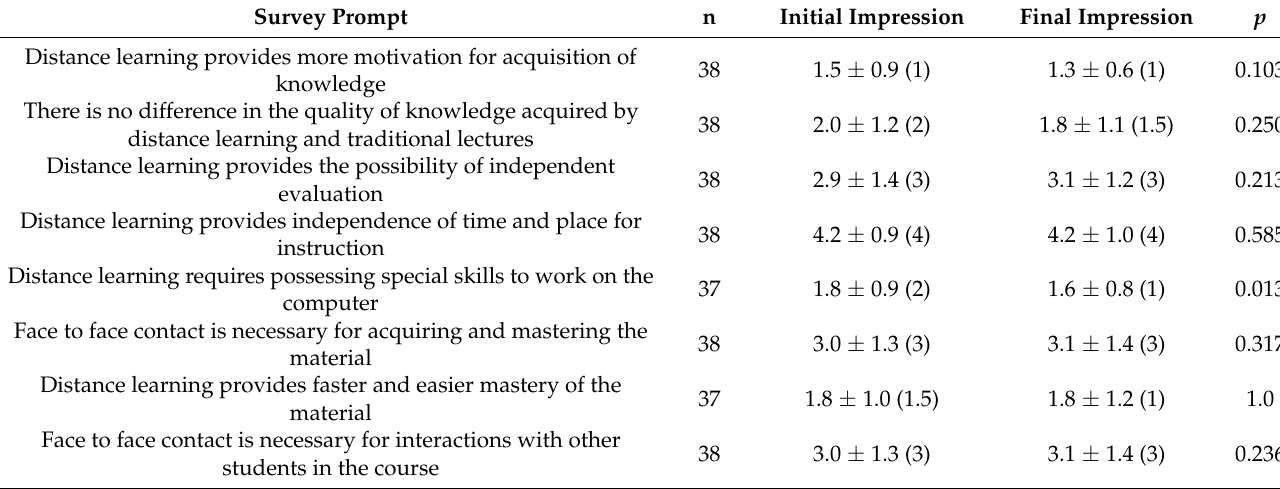
Table 3. Mean Likert scores associated with the following survey questions: before you started this course, how well did you agree with each of the following statements? and after completing the course, how well do you agree with each of the following statements? (1 = not at all, 5 = extremely). Bold text indicates a statistically significant difference. Median values are provided in parentheses. A five-point Likert scale (not at all = 1, slightly = 2, somewhat = 3, moderately = 4, extremely = 5) was used for each of these